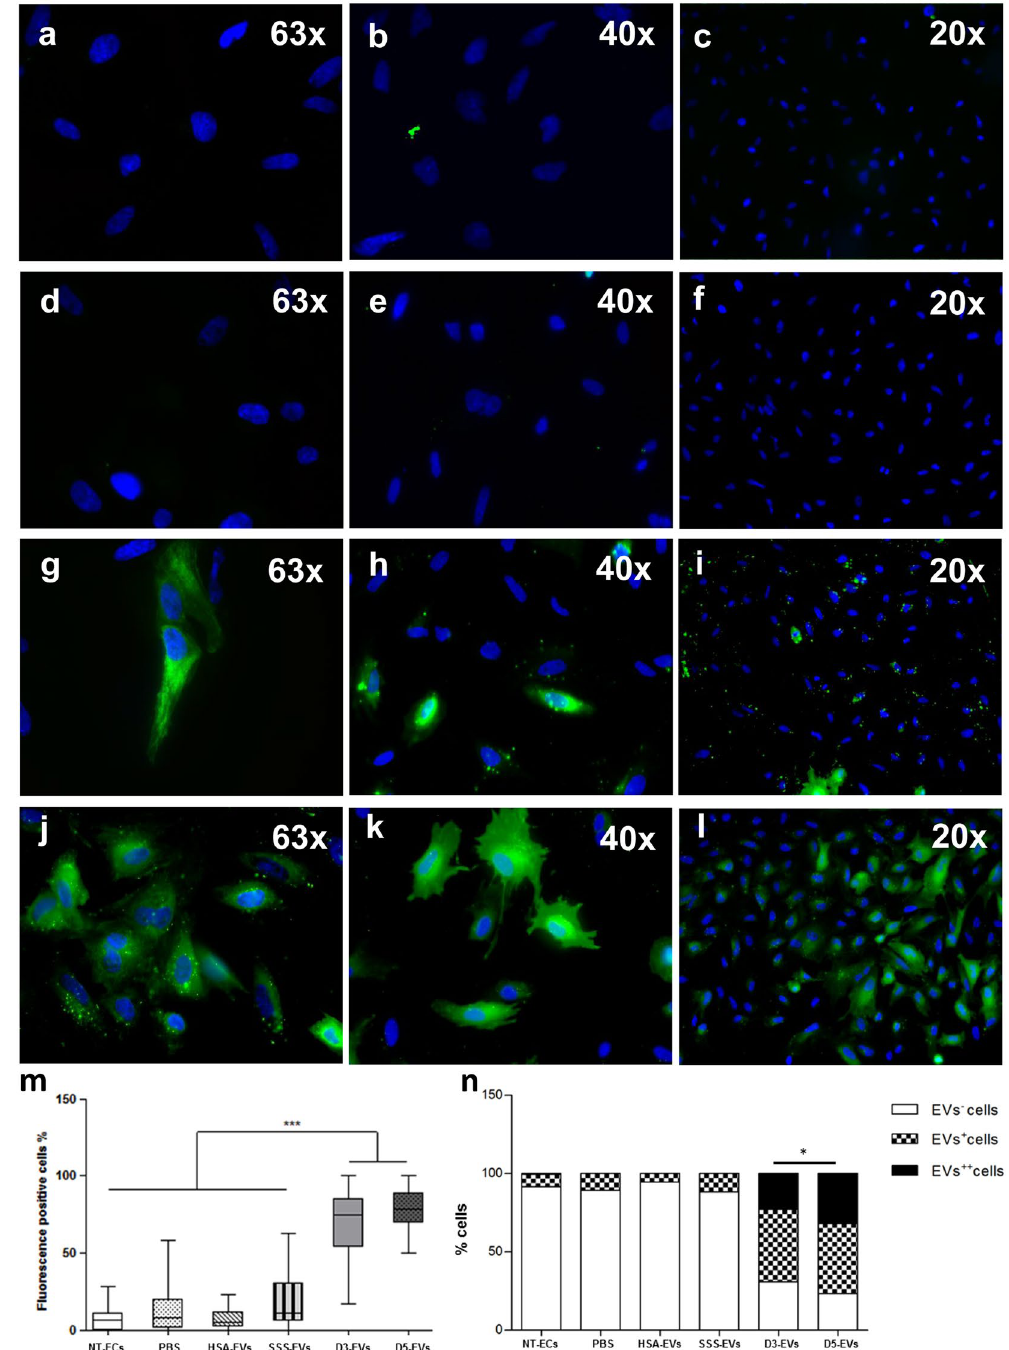
Figure 4. Primary ECs can incorporate embryo-derived EVs. Representative images of primary ECs treated for 4 hours with 10 µ g/ml of Vybrant DiO-labelled EVs derived from 5% HSA-supplemented fresh medium (HSA- EVs) ( a – c ), from 10% SSS-supplemented fresh media (SSS-EVs) ( d – f ) and from conditioned media of day 3 embryos (D3-EVs) ( g – i ) and of day 5 embryos (D5-EVs) ( j – l ). Blue = nuclei. Box plot of percentage of dye- positive cells (EV + plus EV ++ cells). Block lines within boxes represent median value and the whiskers indicate the minimum and the maximum [N = 3, *** P < 0.0001, D3-EVs/D5-EVs vs all negative controls (PBS, HSA- EVs and SSS-EVs)] ( m ); engrafted distributions of fluorescence intensity among the different EV species used for primary cell treatment ( * P = 0.01, D3-EVs vs D5-EVs) ( n